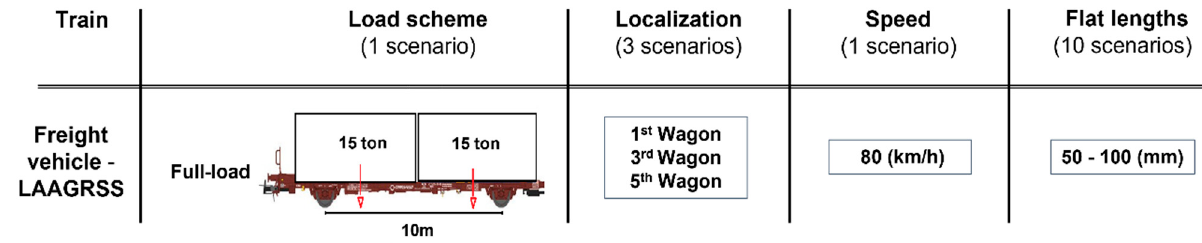
Figure 4. Damaged scenarios.